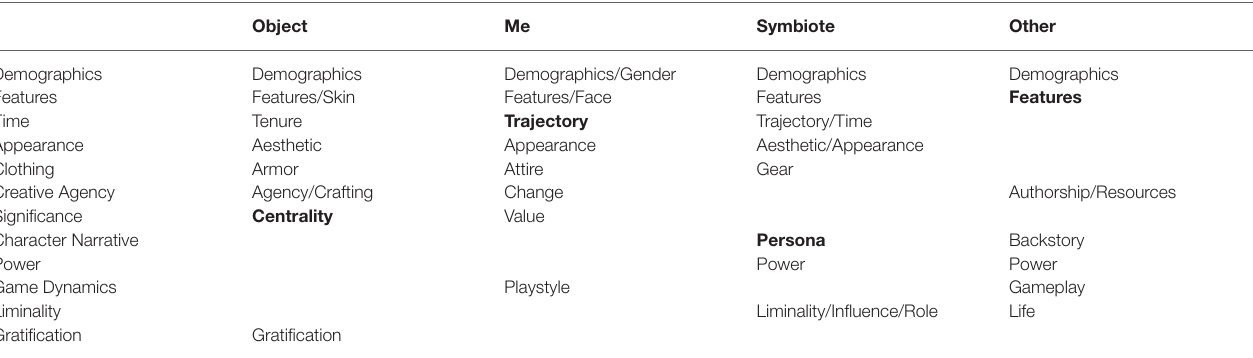
TABLE 1 | Matrix of mental model clusters across PAR